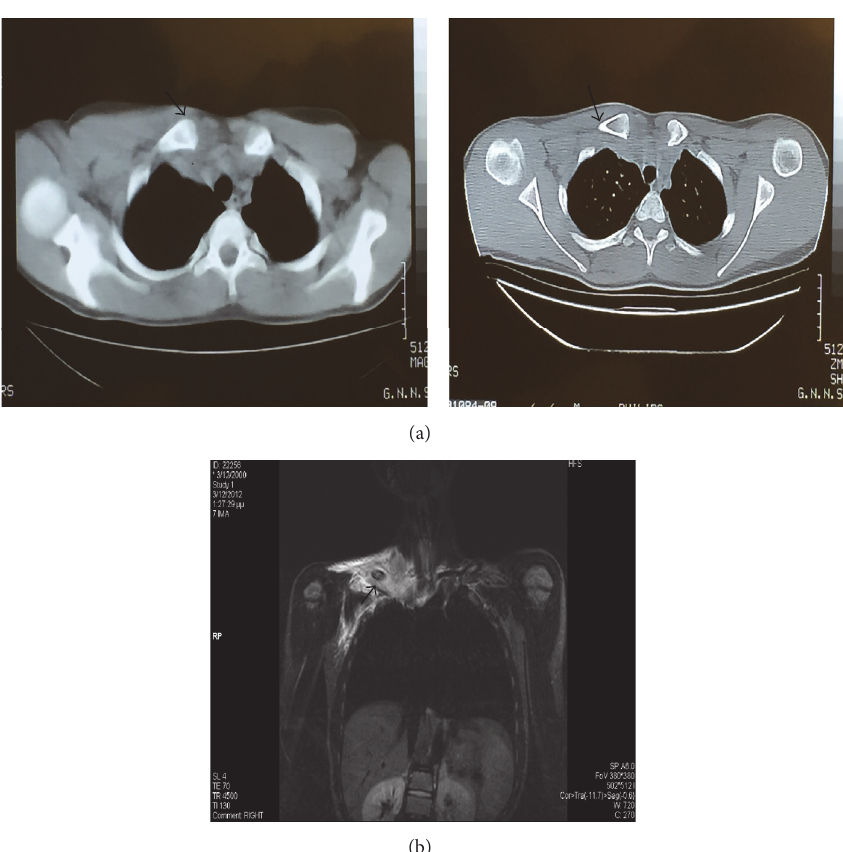
Figure 1: (a) The CT scan showed widening of the soft tissues and the proximal part of the right clavicle without obvious change in the bone marrow and without erosion of the cortex. (b) The MRI showed abnormal signal in the right clavicle with periosteal